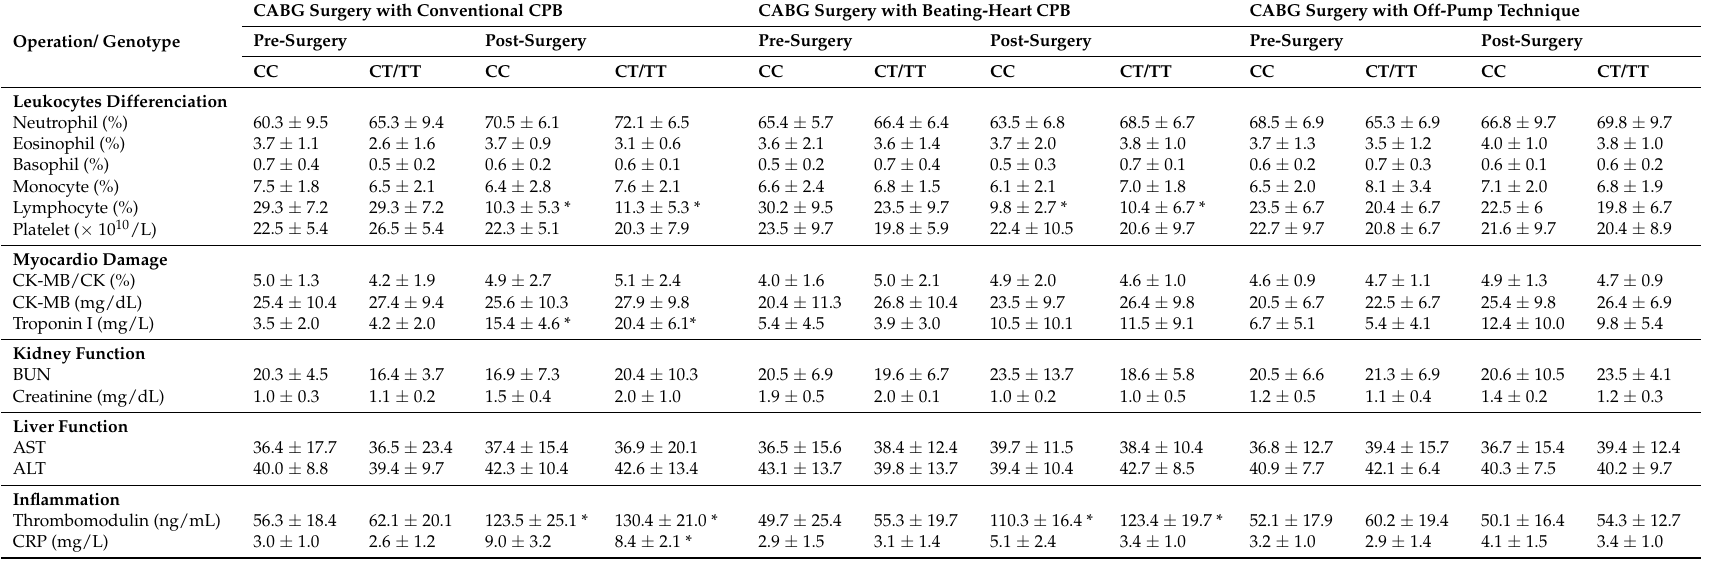
Table 4. Blood and biochemical analysis in elective CABG